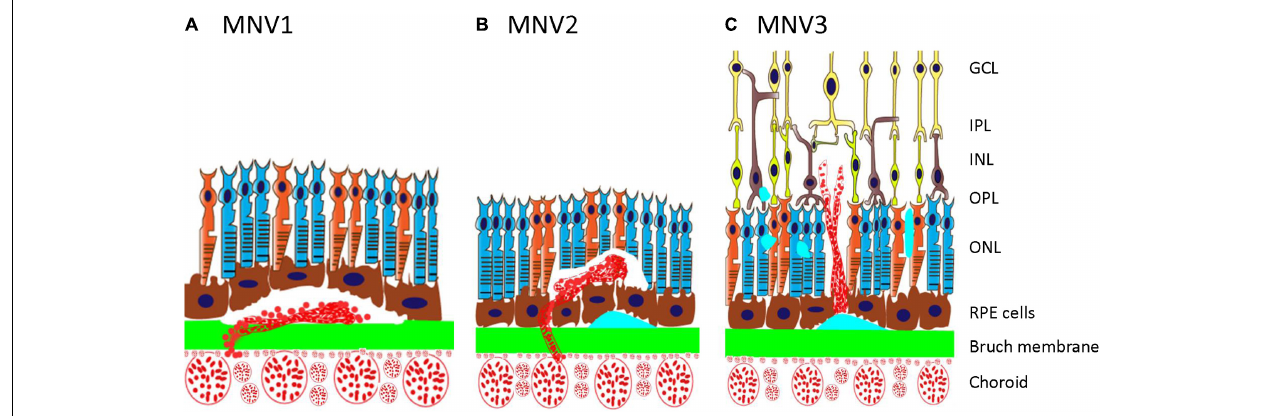
FIGURE 1 | Schematic showing type 1, type 2, and type 3 MNV. (A) Type 1 MNV is an ingrowth of vessels originating from the choriocapillaris into the sub-RPE space. (B) Type 2 MNV is the proliferation of new vessels arising from the choroid into the subretinal space. (C) Type 3 MNV is a downgrowth of vessels from the retinal vascular plexus toward the outer retina. GCL, ganglion cell layer; IPL, inner plexiform layer; INL, inner nuclear layer; OPL, outer plexiform layer; ONL, outer nuclear layer; RPE, retinal pigment epithelium; MNV, macular